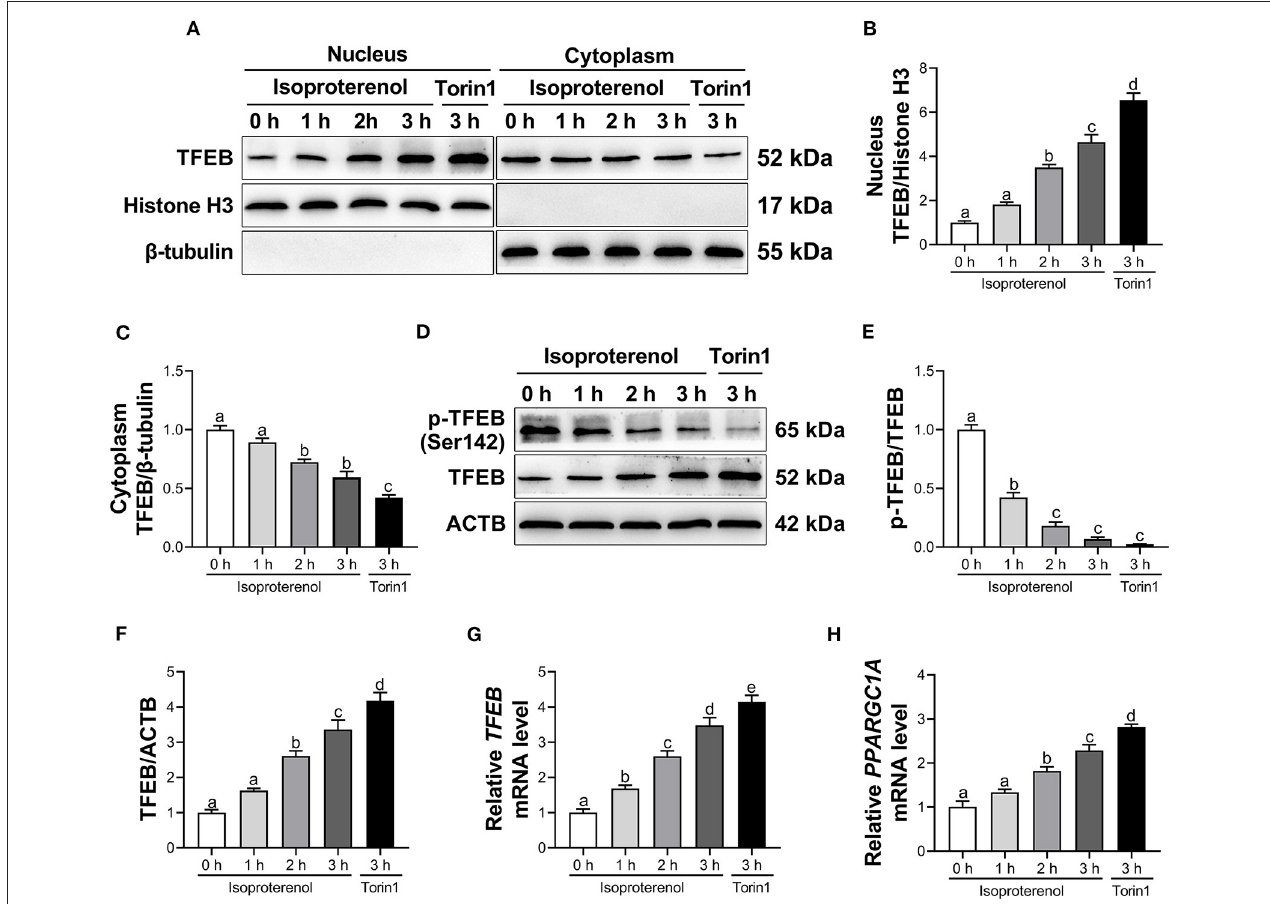
FIGURE 2 | Isoproterenol (ISO) and Torin1 treatment activate transcription factor EB (TFEB) in calf adipocytes. Calf adipocytes were stimulated with 10 µ M ISO for 0, 1, 2, or 3h, or treated with 250 n M Torin1 for 3h. (A) Western blot analysis of TFEB in the nucleus and cytoplasm of calf adipocytes. Representative blots are shown. (B,C) Quantification of protein abundance of nuclear and cytoplasmic TFEB, respectively. (D) Western blot analysis of phosphorylated TFEB (p-TFEB) and total TFEB in calf adipocytes. Representative blots are shown. (E,F) Quantification of ratio of p-TFEB/TFEB and protein abundance of TFEB, respectively. (G,H) Relative mRNA abundance of TFEB and peroxisome proliferator-activated receptor gamma coactivator 1 alpha ( PPARGC1A ) in calf adipocytes. Data were analyzed using one-way ANOVA with Tukey’s tests for data meeting homogeneity of variance or with Tamhane’s T2 analysis for data of heteroscedasticity and expressed as mean ± SEM. The same letter (a-e) indicates no significant difference ( P > 0.05), whereas different letters indicate a significant difference ( P < 0.05).